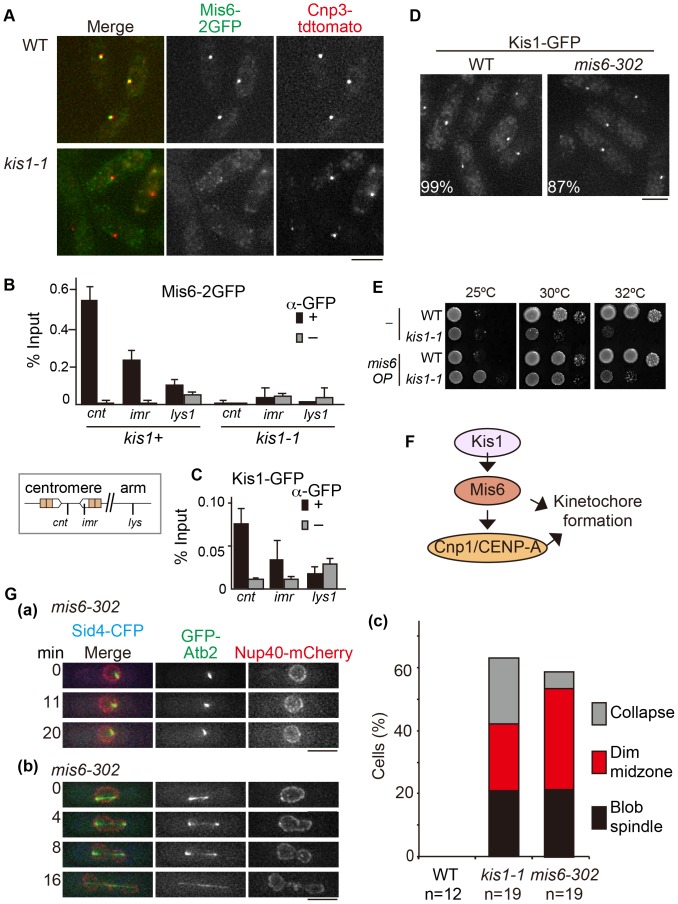
Kis1/Mis19 regulates Mis6 for spindle integrity.(A) Cells coexpressing Mis6-2GFP and Cnp3-tdTomato were imaged. (B,C) ChIP assays. Percentages of DNA precipitates of the centromeric region (cnt and imr) and the arm region (lys1) were measured as scaled to total input DNA using quantitative PCR. Black bars (+), immunoprecipitation with anti-GFP; gray bars (−), mock-treated negative control. Error bars indicate standard deviation (n = 3 reactions) (B) ChIP of Mis6-2GFP in WT or in kis1-1 cells grown at 36°C for 6 h. (C) ChIP of Kis1-GFP. (D) Localization of Kis1-GFP in WT and mis6-302 cells grown at 36°C for 6 h. Percentages indicate the proportion of interphase cells in which Kis1-GFP colocalized with both Cnp3-tdTomato and Sid4-CFP. (E) Ten-fold serial dilution assay. WT or kis1-1 cells expressing either GFP (−) or Mis6-GFP (mis6) were grown on EMM plates at 25, 30, or 32°C. (F) A proposed model for localization dependency of Kis1/Mis19, Mis6 and Cnp1/CENP-A at kinetochores. (G) (a,b) Spindle phenotypes of mis6-302 cells. Time-lapse imaging of GFP-Atb2, Nup40-mCherry, and Sid4-CFP in mis6-302 was done at 36°C (6–9 h). (a) Blob spindles; (b) spindles with the dim midzone; (c) frequencies of spindle defects in WT, kis1-1, and mis6-302 cells. Scale bars, 5 µm.